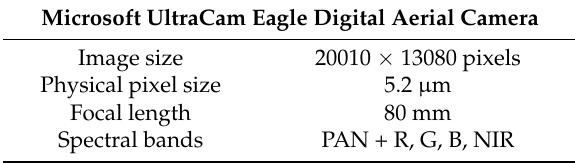
Table 1. Microsoft UltraCam Eagle photogrammetric large-format digital aerial camera specification.